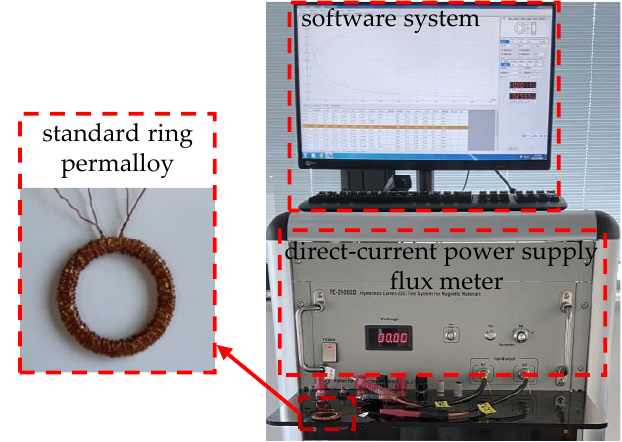
Figure 2. The outline of the common test system.